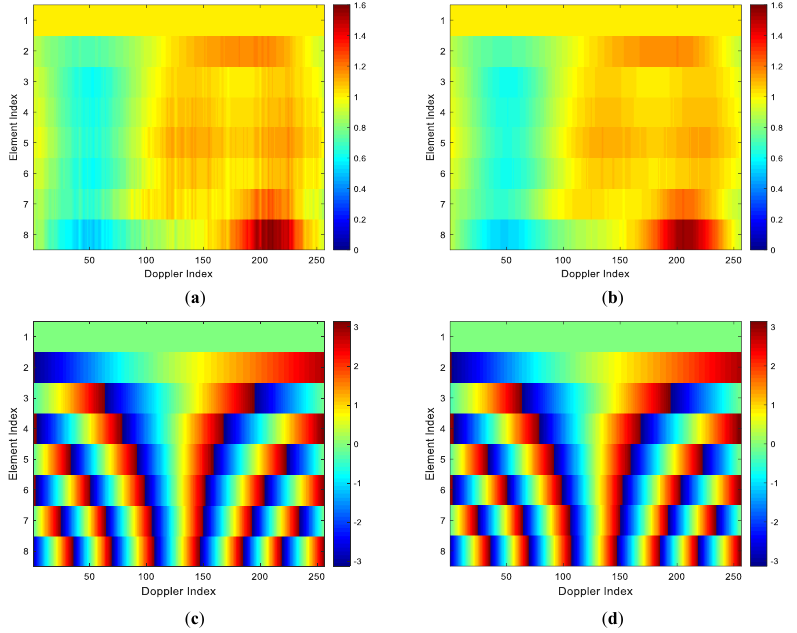
Figure 8. Steering vector estimation results of all Doppler bins. ( a ) Amplitudes of estimated steering vectors; ( b ) Amplitudes of true steering vectors; ( c ) Interferometry phases of estimated steering vectors; ( d ) Interferometry phases of true steering